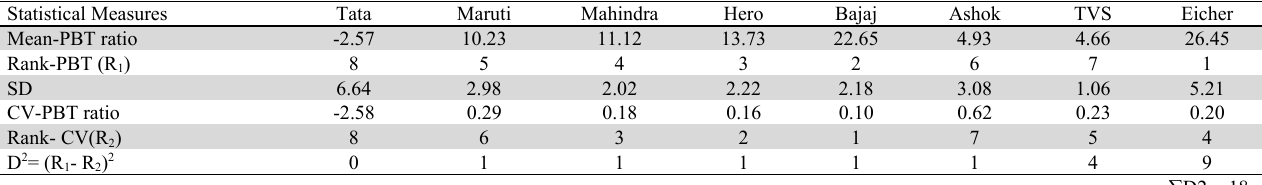
Relational Co-variability of average PBT ratio and variability of PBT ratio of leading Indian automobile companies (2011 to 2020) Statistical Measures Tata